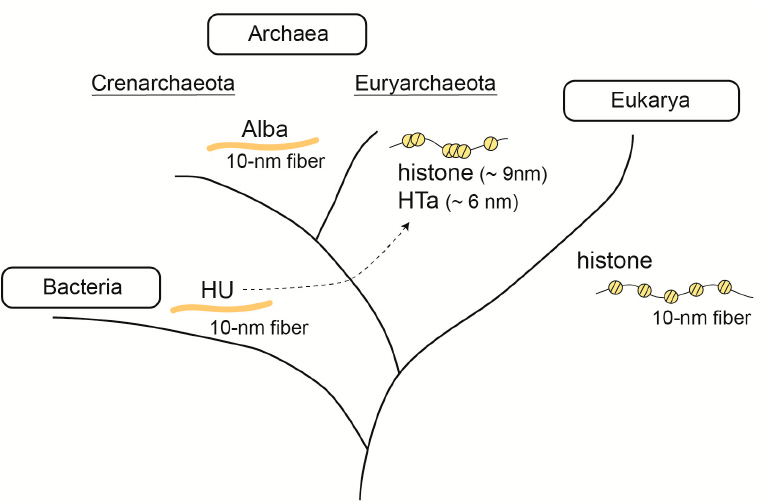
Figure 1. Initial steps of genome folding in the three domains of life. In Eukarya, the nucleosome formed by histone is the fundamental unit of genome structure. In bacteria, the conserved protein HU forms a fibrous structure on DNA. In archaea, euryarchaeota encodes DNA-wrapping proteins, histone or HTa. The archaeal histone forms “hypernucleosome”, which consist of varying numbers of histone dimers. HTa have horizontally transferred from bacteria to archaea at some point. Alba is widely distributed among archaea and is capable of forming fibrous